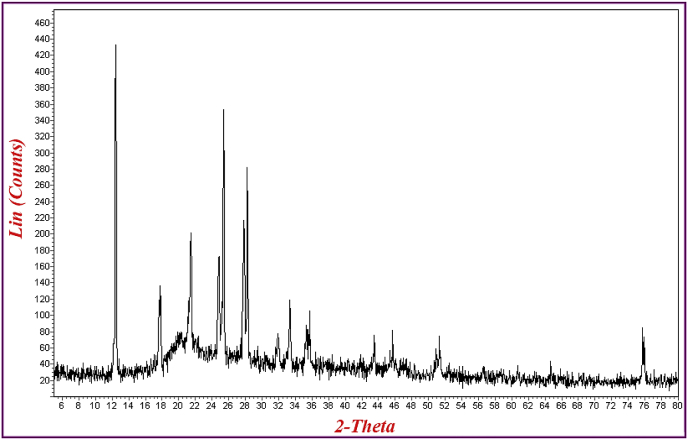
XRD patterns of the synthesized SiO2/functionalized chitosan composite.